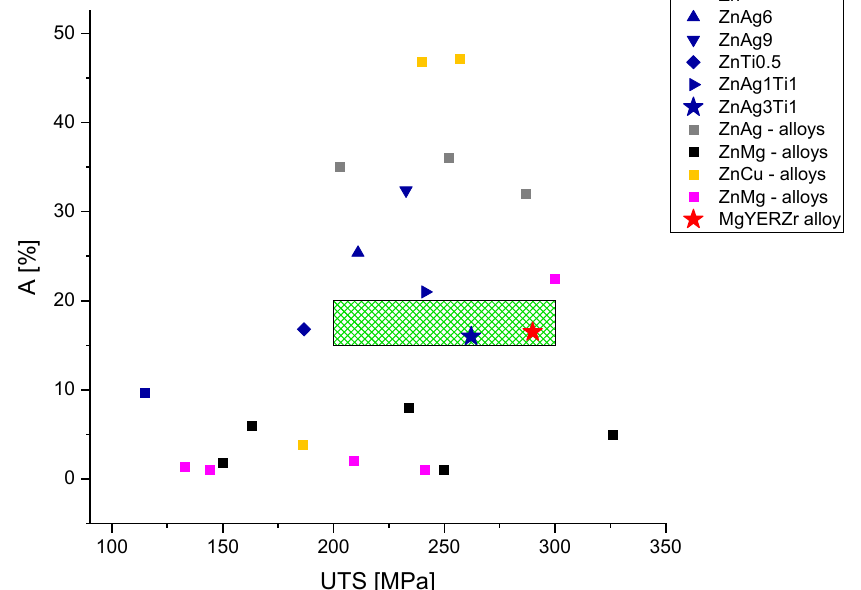
Figure 6. Comparison of elongation at fracture (A) and ultimate tensile strength (UTS) of the alloys measured in this study (blue icons) with measurements reported in the literature [30,52–58]. The area highlighted in green corresponds to the target values given in the literature of an elongation at fracture between 15 to 20% and an ultimate tensile strength between 200 to 300